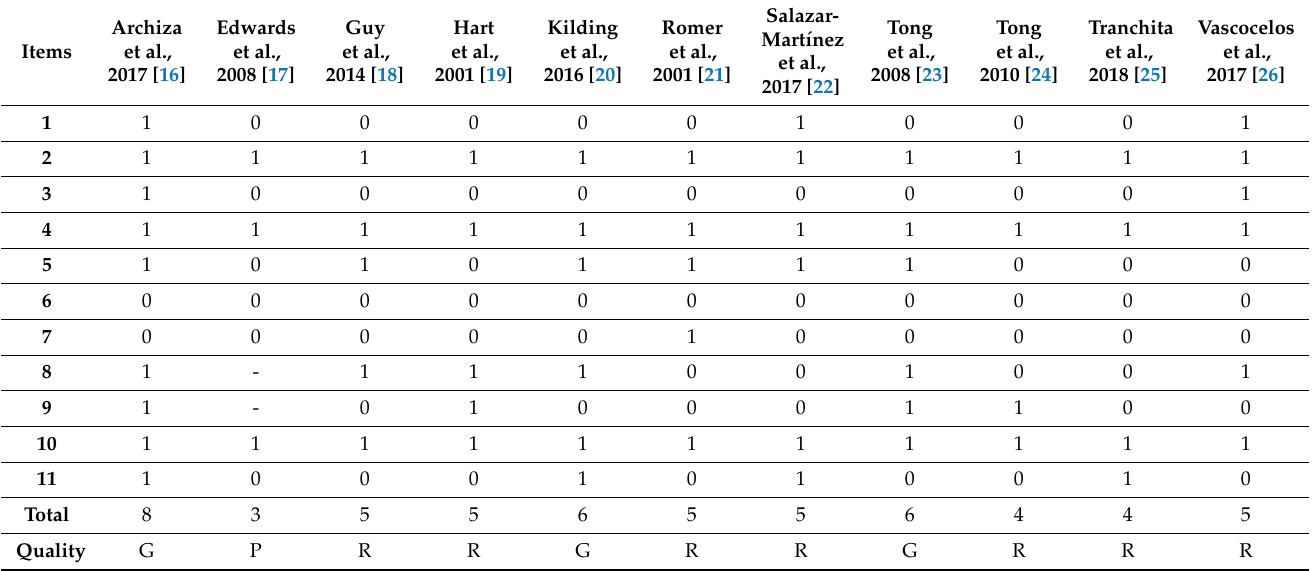
Table 4. Results of the methodological quality assessment of included studies—PEDro Scale